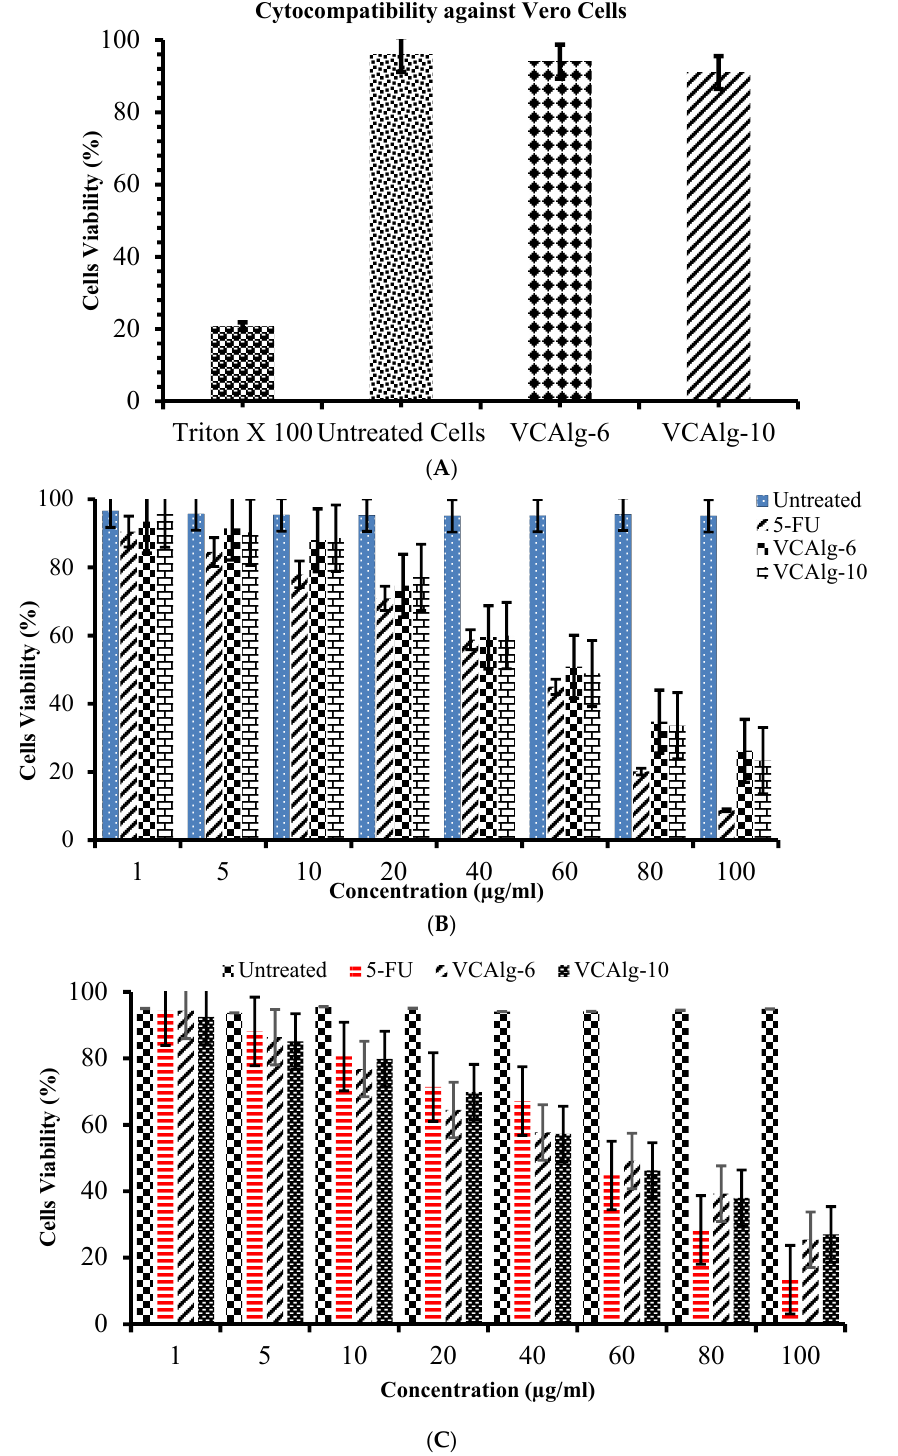
Figure 13. In vitro cytocompatibility sketch of bare thermoresponsive chemically grafted Poly (NVCL- g-NaAlg) in situ depot gels against Vero cell lines using MTT assay ( A ). Cytotoxicity evaluation of chemically grafted Poly (NVCL-g-NaAlg) in situ depot gels against Human cervical (HeLa) cancer cell lines ( B ). Cytotoxicity evaluation of chemically grafted Poly (NVCL-g-NaAlg) in situ depot gels against MCF-7 cancer cell lines ( C ). Data reported show mean ± SD of (n = 3). The data were tested with one-way ANOVA and found significant with p -value of